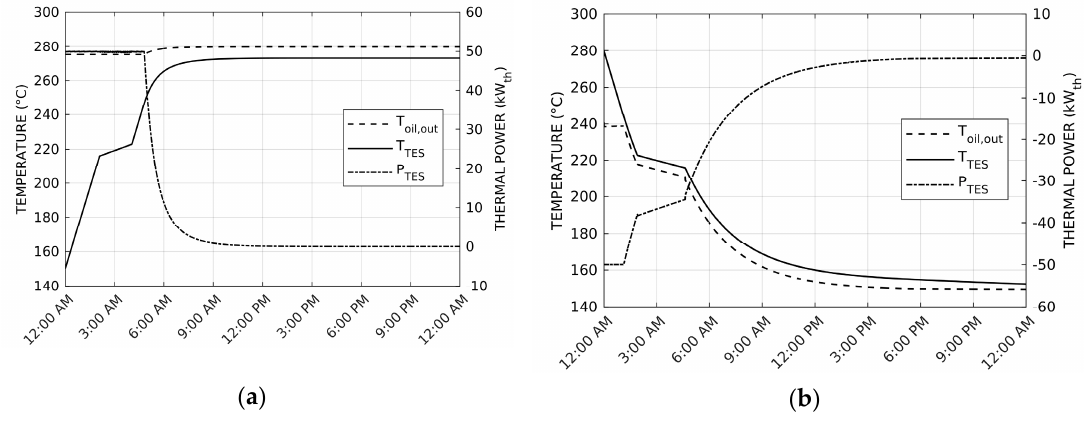
Figure 2. Charging ( a ) and discharging ( b ) process of the LHTES.